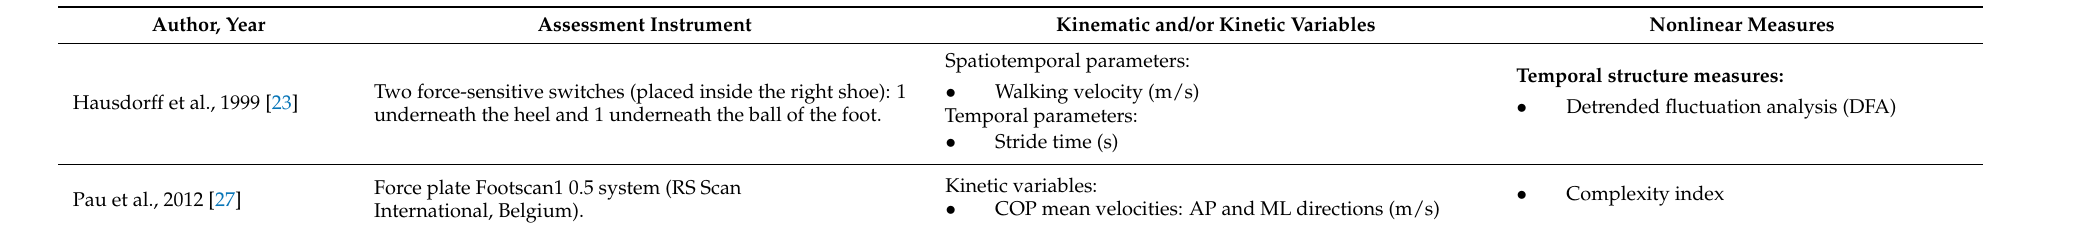
Table 3. Assessment instruments, kinematic and kinetic variables, and nonlinear